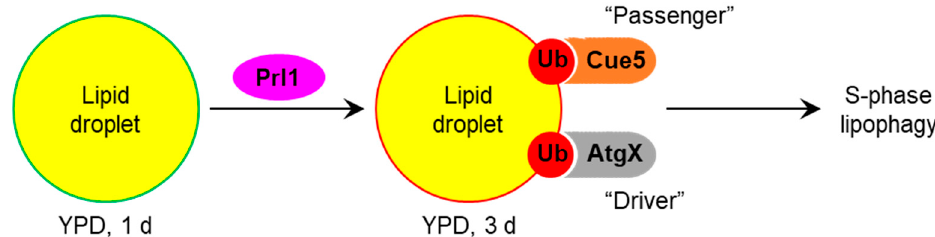
Figure 6. Relationship of K. phaffii Cue5 with LDs and lipophagy. In S-phase, Cue5 accumulates on LDs and is degraded together with LDs via S-phase lipophagy. The accumulation of Cue5 on LDs and its vacuolar degradation strongly depend on the ubiquitin-binding CUE domain and Prl1, the positive regulator of lipophagy 1. Since Cue5 is dispensable for the S-phase lipophagy, it is rather a new “passenger” of this trafficking route. However, a similar mechanism might be employed by Prl1 to recruit another ubiquitin-binding protein (AtgX) that will “drive” S-phase lipophagy.